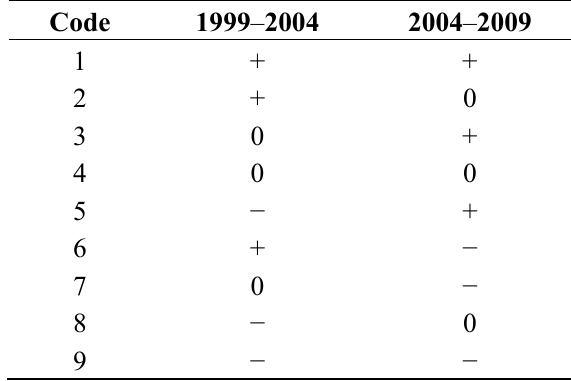
Table 3. Permutations and combinations of three vegetation-change states for two time intervals, in which “+” represents the increased state, “ − ” represents the decreased state and “0” represents the unchanged